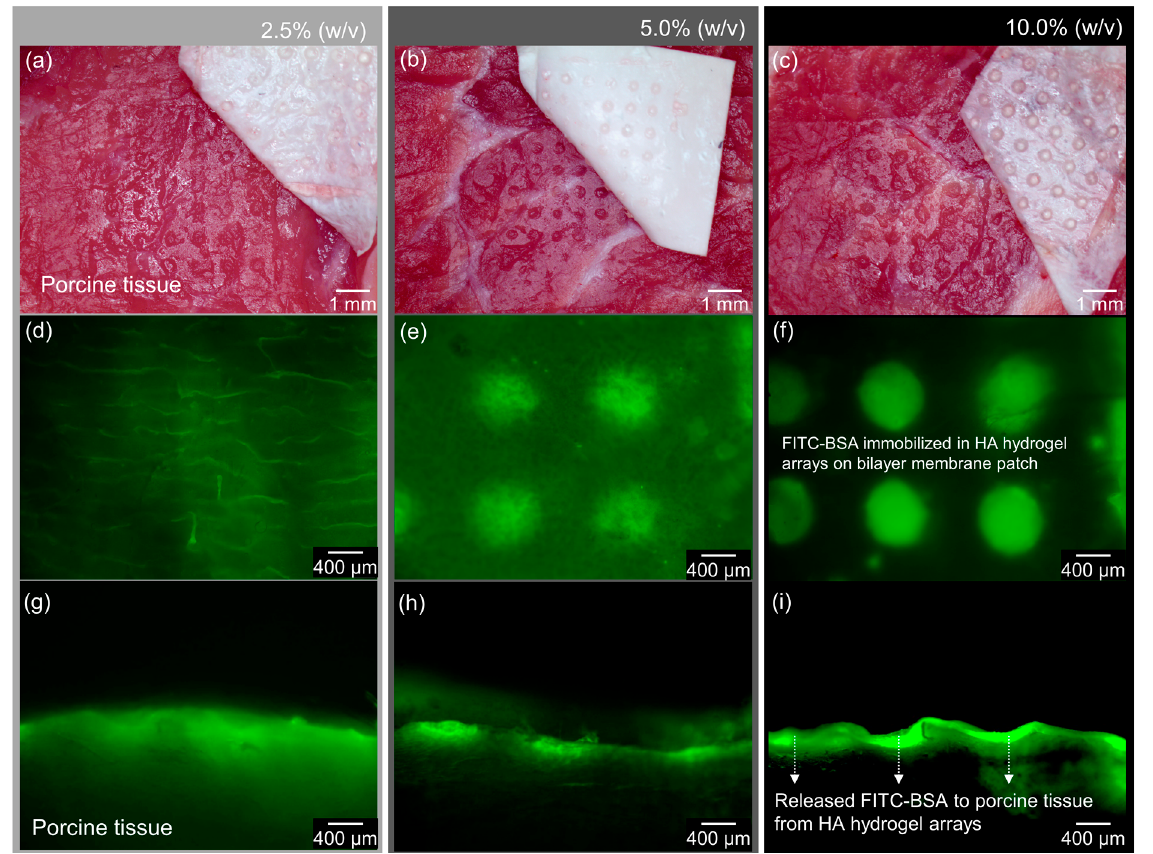
Figure 7. Images of the porcine tissue with the bilayer membrane containing the FITC-BSA-immobilized HA hydrogel array. ( a ) HA hydrogel array at a concentration of 2.5% ( w/v ), ( b ) HA hydrogel array at a concentration of 5.5% ( w/v ), ( c ) HA hydrogel array at a concentration of 10% ( w/v ), ( d – f ) different expression of fluorescence in HA hydrogel arrays on bilayer membranes at concentrations of 2.5, 5, and 10% ( w/v ), and ( g – i ) diffused fluorescence from HA hydrogel arrays on bilayer membranes to porcine tissue.